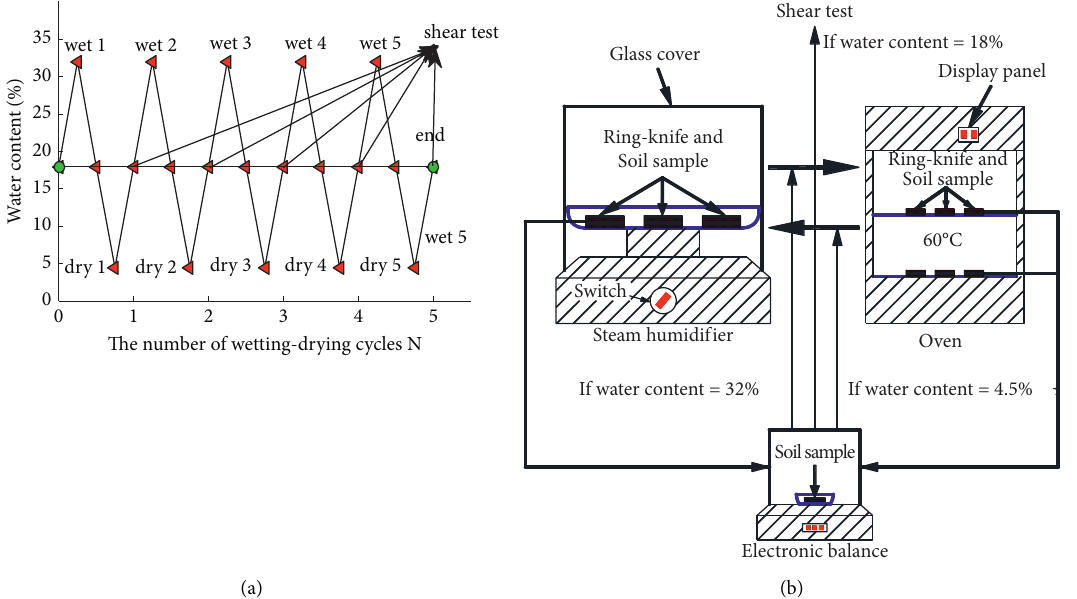
Figure 2: Schematic of the cyclic wetting-drying test procedure. (a) Test procedure. (b) Wetting-drying cycle test